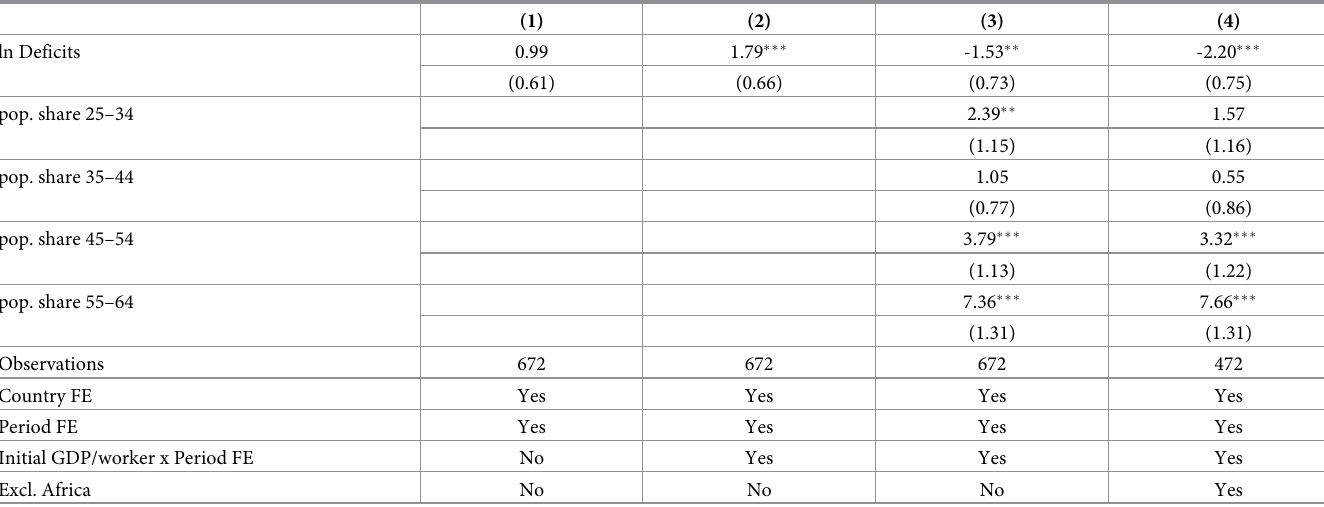
Table 3. Physiological aging and economic